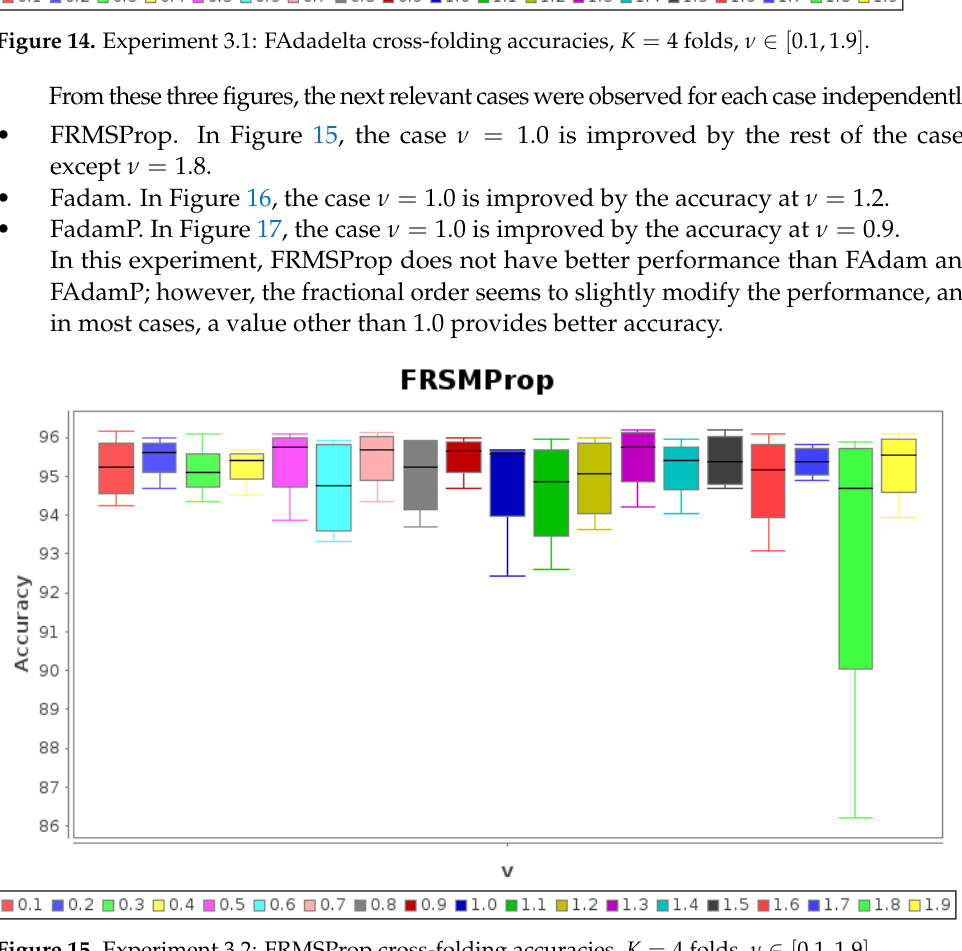
Figure 15. Experiment 3.2: FRMSProp cross-folding accuracies, K = 4 folds, ν ∈ [ 0.1,1.9 ]